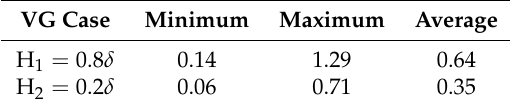
Table 4. Wall dimensionless distance y+ values for the two VG cases